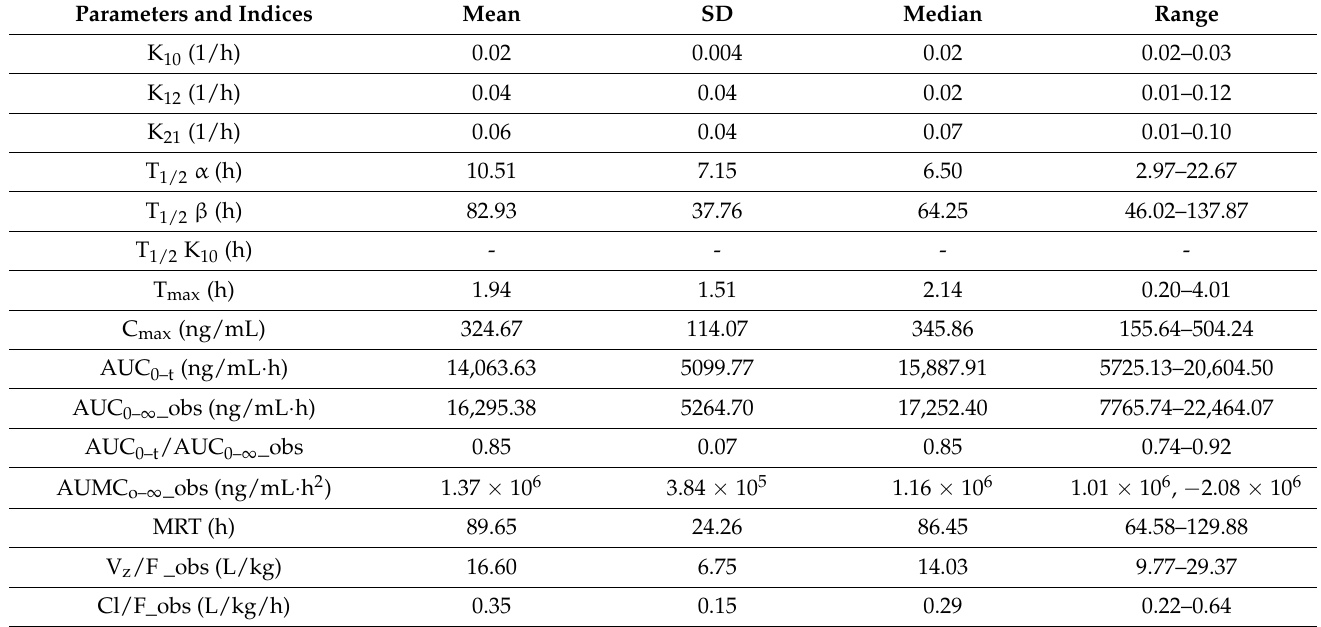
Table 4. Mean ± SD, median, and range of the pharmacokinetic parameters and indices for doxy- cycline in koala plasma determined over the first seven days after administration of doxycycline at 5 mg/kg via subcutaneous injection (diluted at 50:50 with saline).